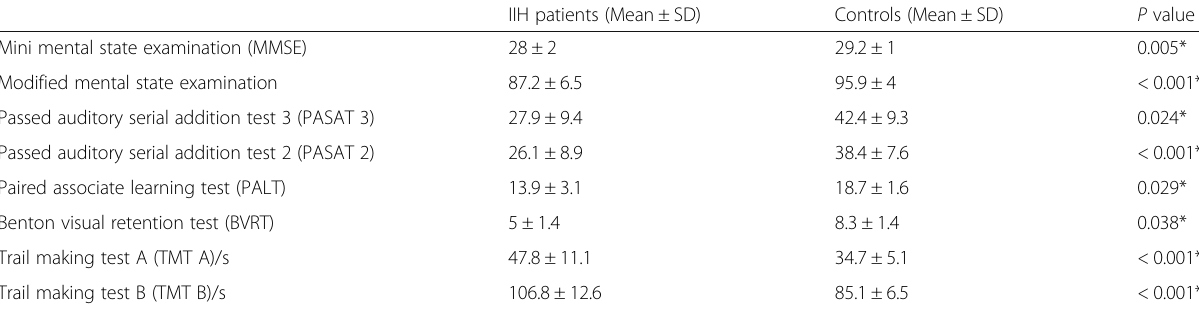
Table 4 Comparison between results of psychometric tests in both